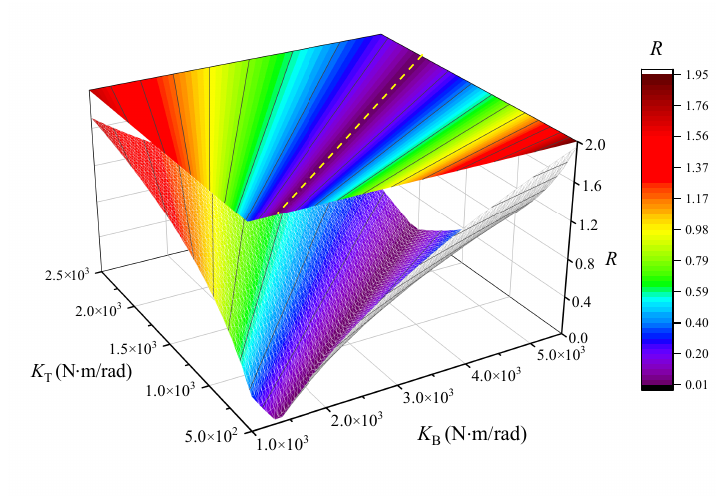
Figure 8. Changes in flutter modal amplitude ratio R with A B and A T